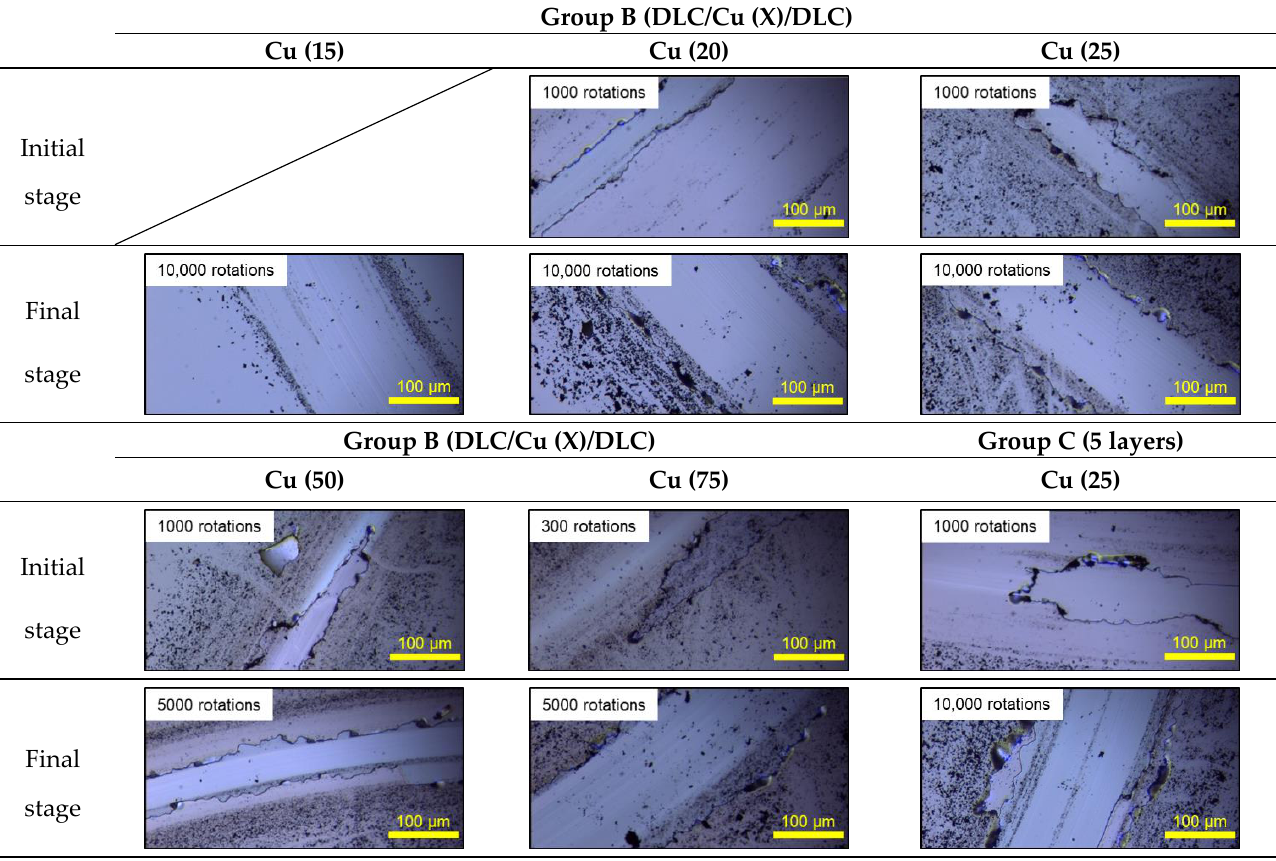
Figure 13. Appearance on the tapes of the 11-layer films after peeling.